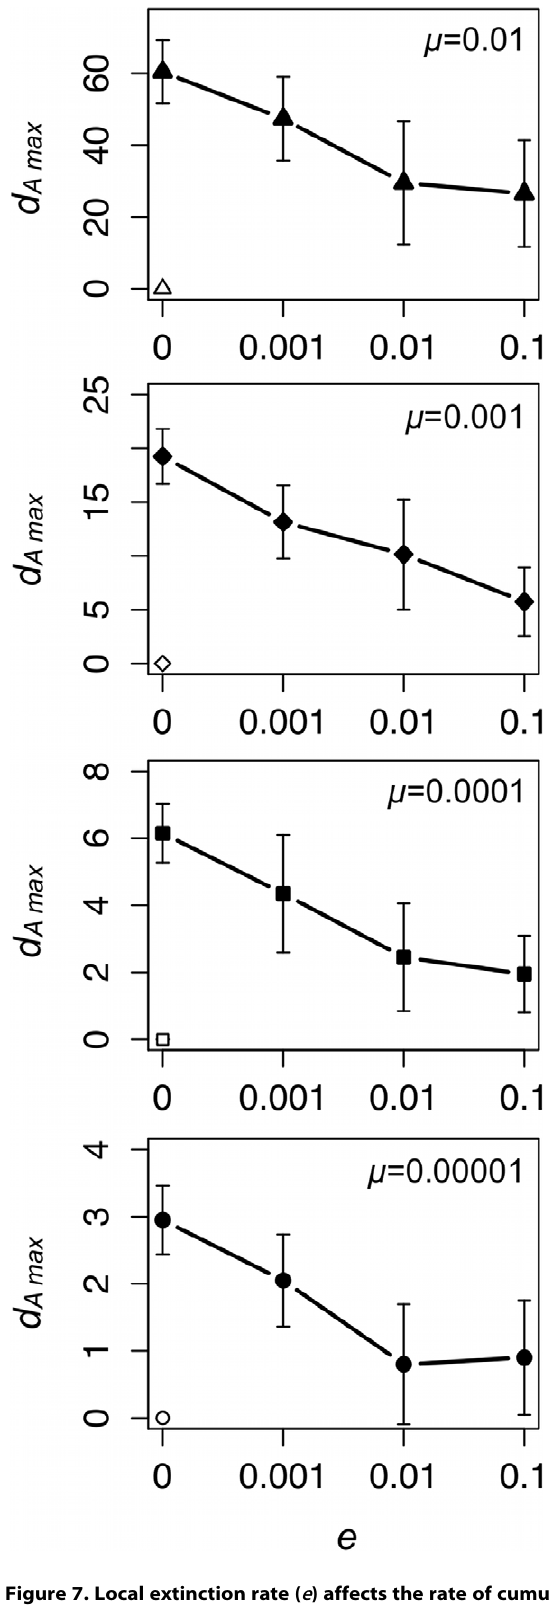
Figure 7. Local extinction rate ( e ) affects the rate of cumulative cultural change ( d A max ). Each data point provides the mean 6 1 standard deviation of 20 unique simulated populations. Black symbols represent data collected from populations with unbiased cultural